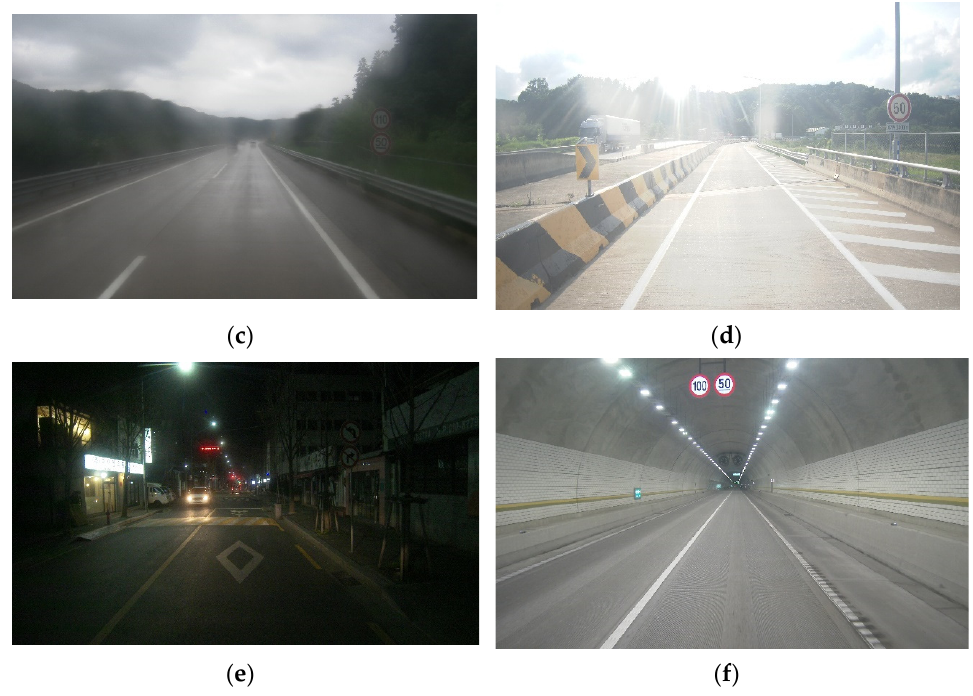
Figure 3. Examples for each environment category: ( a ) Clean, ( b ) Cloud, ( c ) Rain, ( d ) Sunlight, ( e ) Night, and ( f ) Tunnel.